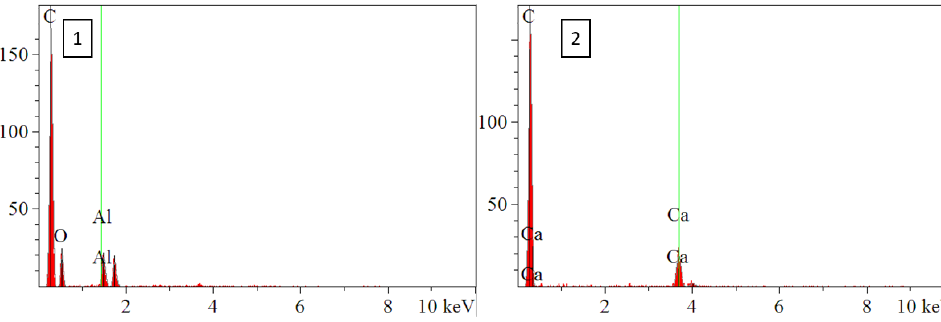
Figure 5. EDS spectra of ABS w/CNT showing presence of impurities. Numbers 1 and 2 correspond to the respective areas in Figure 4b. Table 1. Tabulated EDS spectra data corresponding to Figures 2b and 4b.